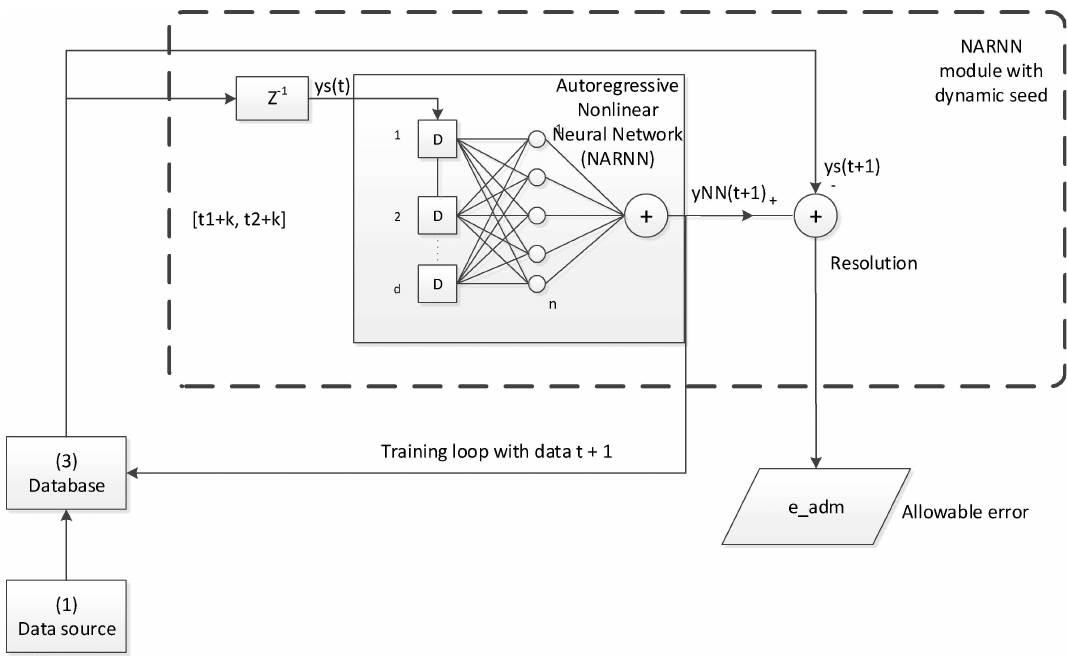
Figure 6. Dynamic seed NARNN validation algorithm.